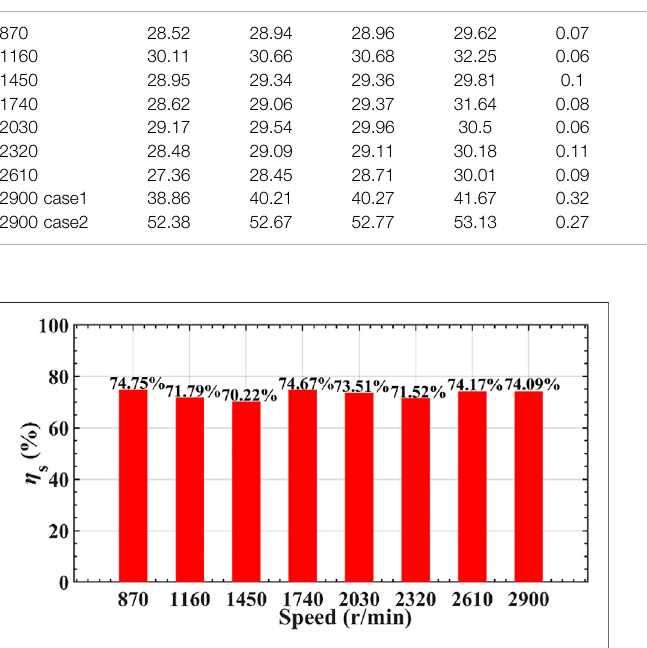
TABLE 3 | Constraints of the optimization process. Speed (r/min)